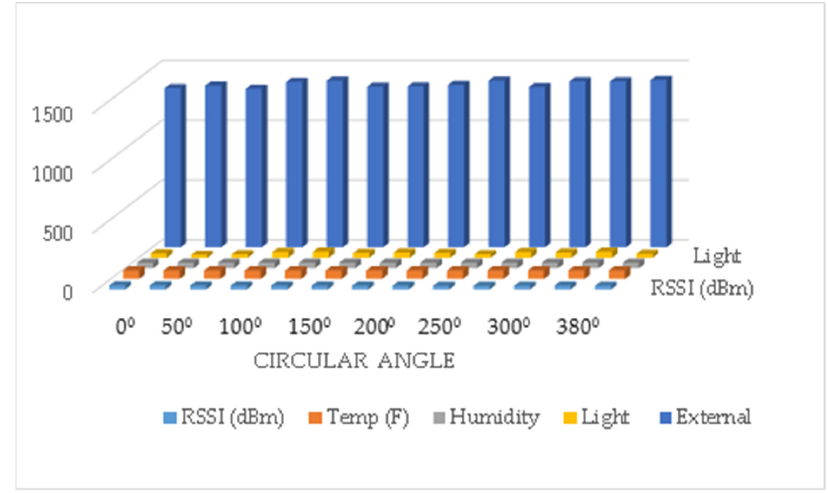
Electronics 2023 , 12 , x FOR PEER REVIEW Figure 6. 0° Sense Data from Patch Antenna. Figure 6. 0 ◦ Sense Data from Patch Antenna.